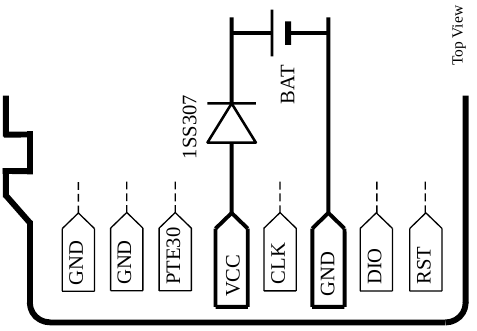
Figure 2. Connector used in the underwater sensor node with identification of terminals